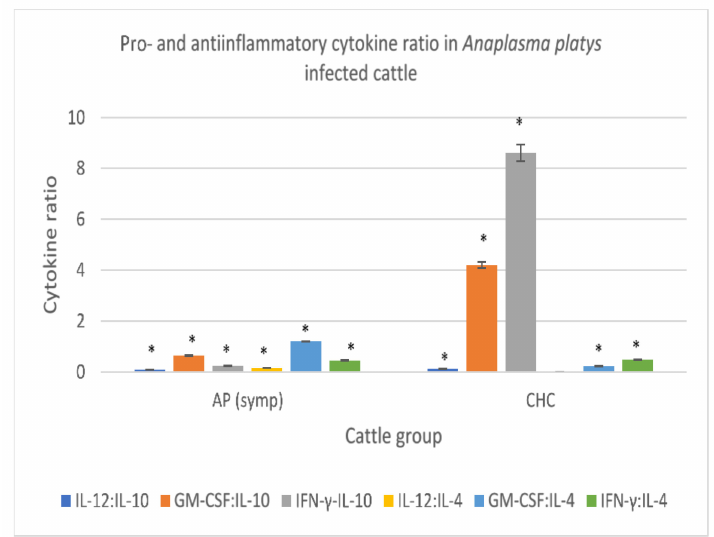
Figure 6. Pro- and anti-inflammatory cytokine ratio in symptomatic cattle infected with Anaplasma platys . Molecular detection and confirmation of Anaplasma platys was by PCR amplification of the 16S rRNA gene using species-specific primers. Low serum IL-12:IL-10, GM-CSF:IL-10 and IFN-y:IL-10, and high GM-CSF:IL-4 ratio was observed in the symptomatic cattle infected with Anaplasma platys . AP (Symp): Symptomatic Anaplasma platys infected cattle. CHC: Clinically healthy cattle (control). IL-12: Interleukin 12; IL-10: Interleukin 10; GM-CSF: Granulocyte Macrophage-colony stimulating factor; IFN- γ : Interferon gamma; IL-4: Interleukin 4. * Asterisk superscript on a parameter indicates significant difference p <